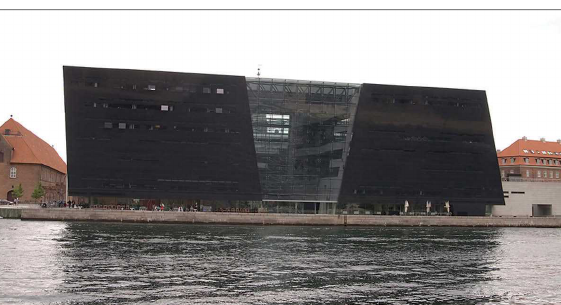
4 pav. Karališkoji biblioteka „Juodasis deimantas“ Kopenhagoje (1999 m.) Fig 4 . Royal Library “Black diamond“ in Copenhagen (1999)